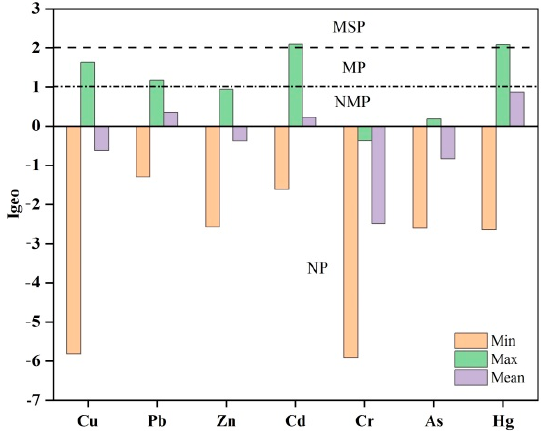
Figure 6. Histogram of the Igeo in the surface sediment of Xiamen Bay (NP = no pollution; NMP = no